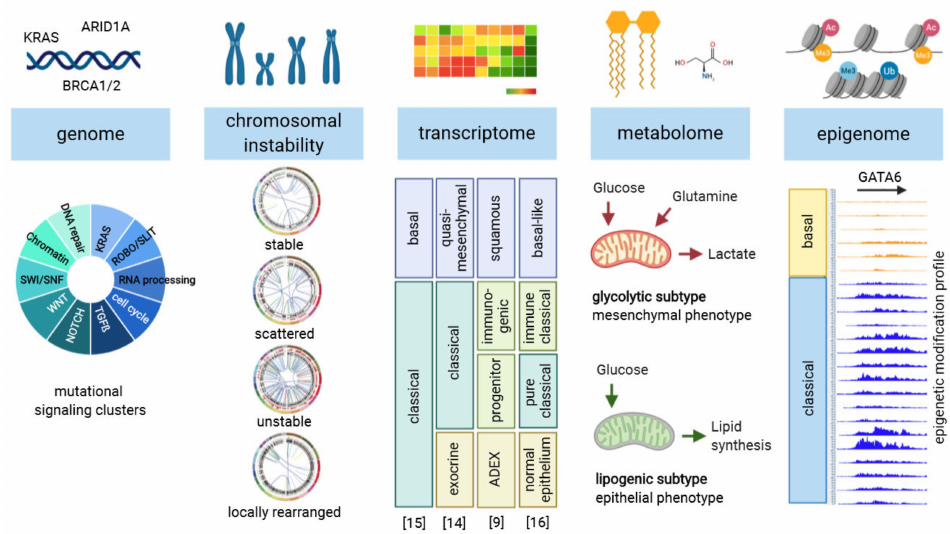
Figure 1. Subtyping of pancreatic ductal adenocarcinoma based on various molecular tumor features. Genome wide mutations, detected in pancreatic ductal adenocarcinoma (PDAC) tissue, cluster in specific pathways that are associated to cancer formation [9]. Analysis of chromosomal instability and structural rearrangements revealed four di ff erent PDAC subtypes [10]. Transcriptomic cluster analysis shows a variation in PDAC subtypes when compared in di ff erent studies [9,14–16]. Metabolome analysis of PDAC displays a separation into a glycolytic and lipogenic tumor subtype [17]. The epigenomic landscape of PDAC tissue reflects the classical and basal transcriptomic subtypes, data adapted from